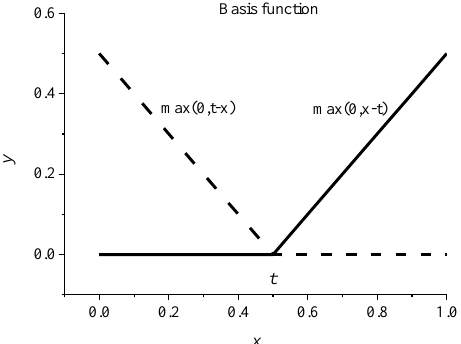
Figure 1. A graphical representation of a spline basis function: The left spline (max (0, t − x )) is shown as a dashed line and the right spline (max (0, x − t )) is shown as a solid line.